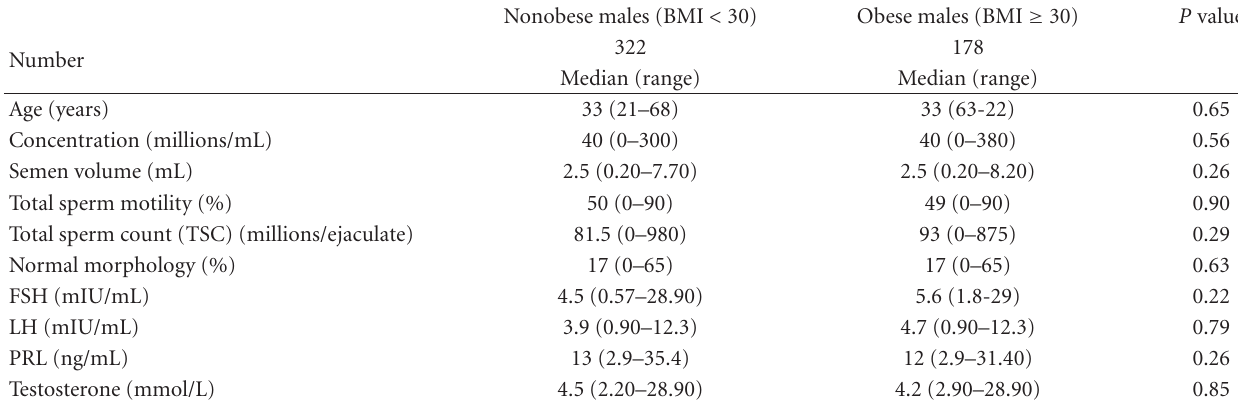
Table 2: Clinical hormonal and semen parameters of the 2